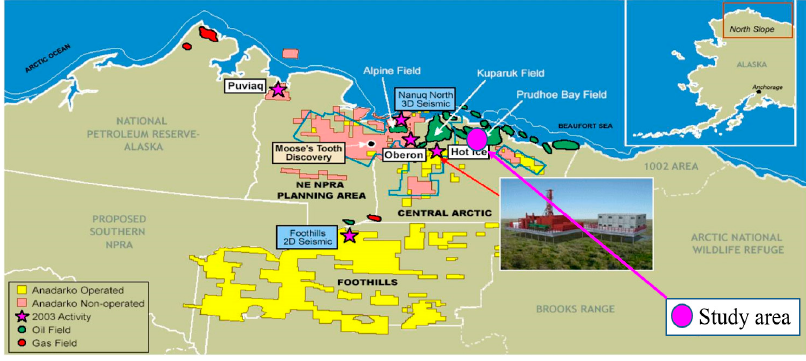
Figure 4. Location of the study area in this work (modified from [26]).